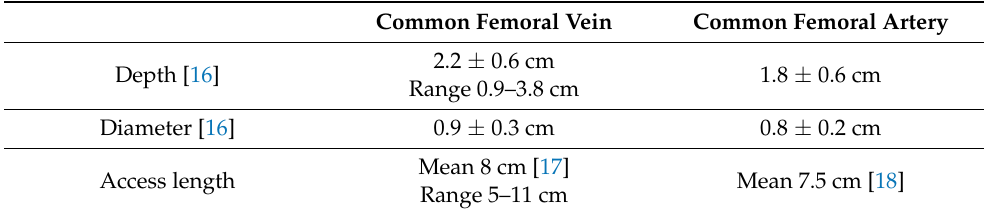
Figure 1. Femoral blood vessel anatomy [14] (art modeled after [15]). Table 1. Anatomical parameters relevant to human femoral vascular access. Depth is defined as distance from the skin surface to the anterior vessel wall.